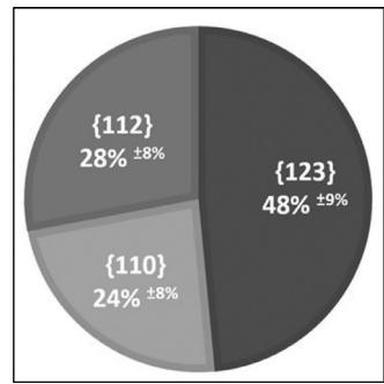
Pie chart showing the probability distribution of possible slip plane families using the slip line detection algorithm for the total of 123 slip events.